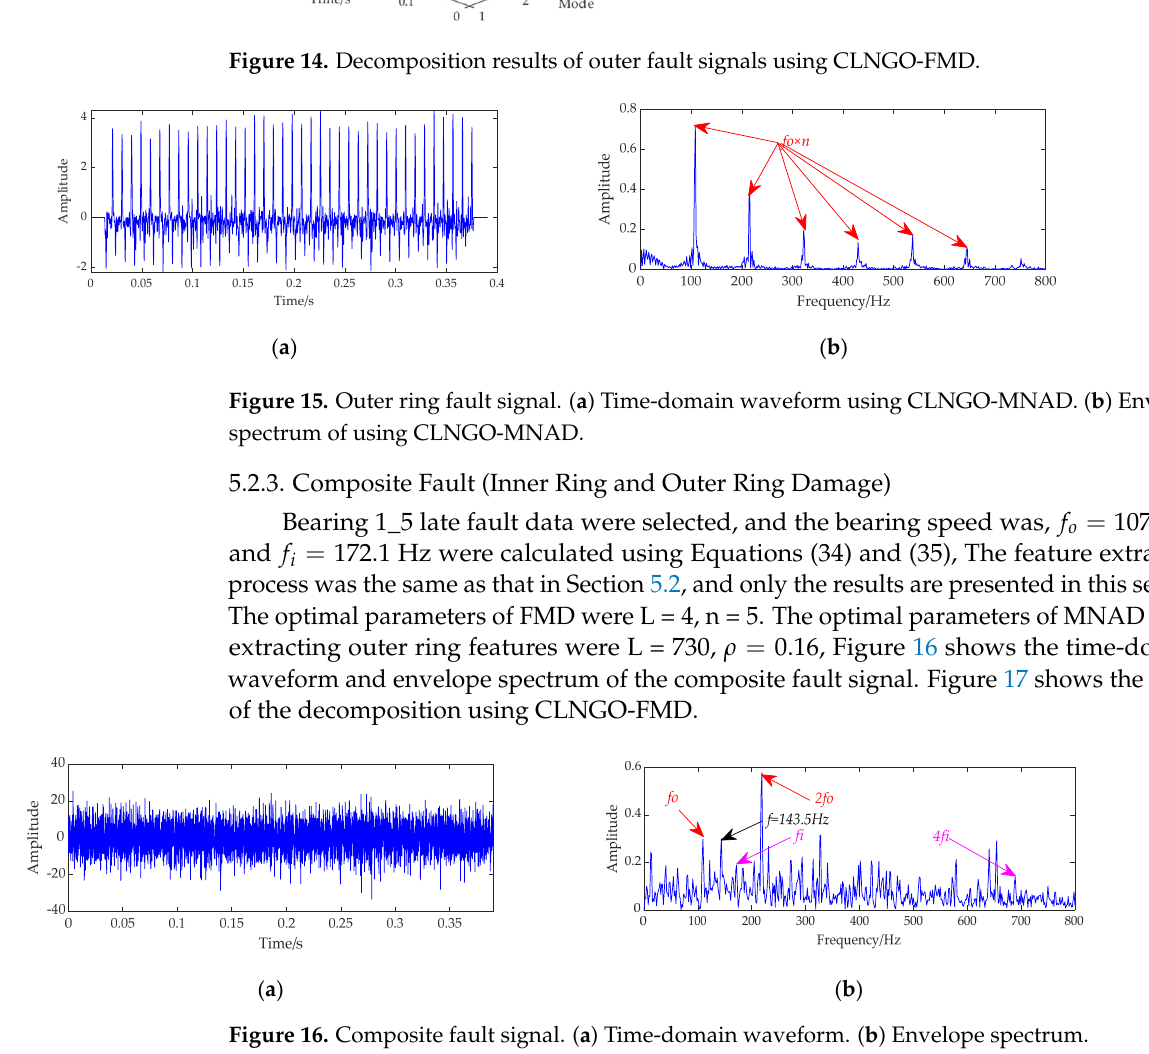
Figure 17. Decomposition results of composite fault signals using CLNGO-FMD. By observing mode 1 in Figure 17, the impact component was obvious and periodi- cally distributed. The envelope analysis of mode 1 is shown in Figure 18,